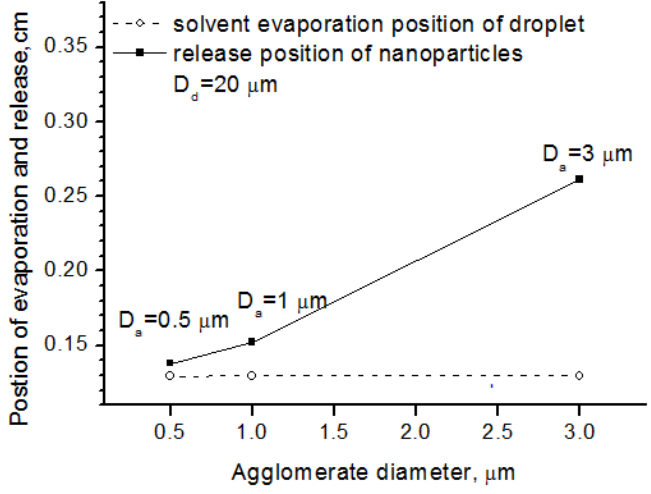
Figure 8. Solvent evaporation position and release position for different agglomerate diameter.